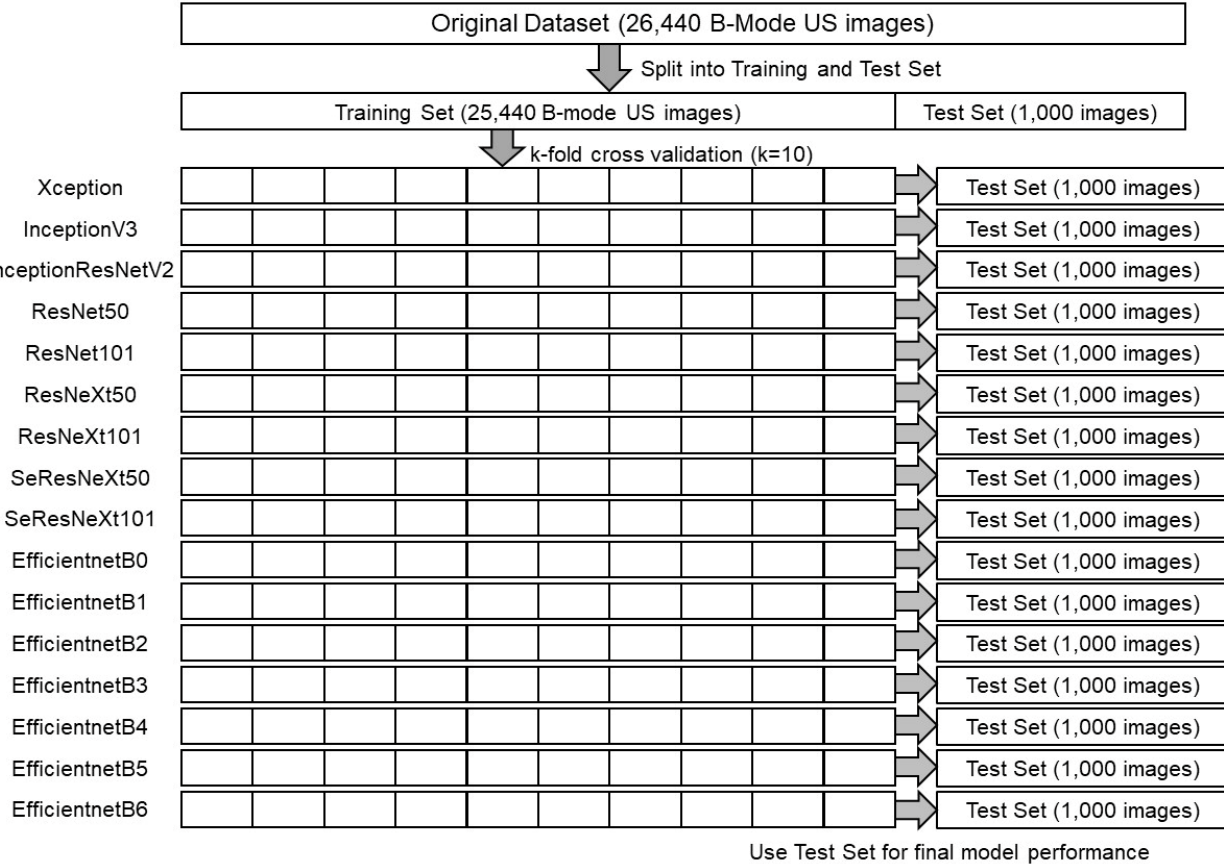
Figure 2. A schematic of training and tests of 16